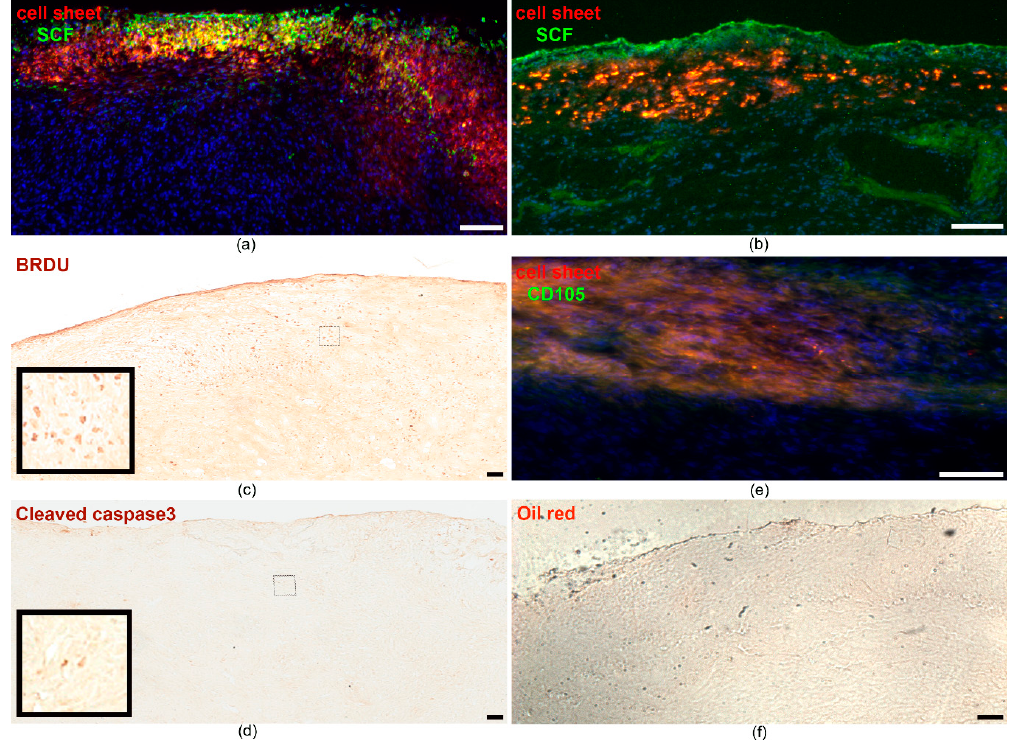
Figure 3. SCF-MSC CS integration into myocardium tissue and transgene expression at day 5 ( a ) and 14 ( b ) after MI induction. Representative images of the infarction area that is covered by the cell sheet comprised of PKH26-labeled cells (red). Specific staining indicates SCF protein (green) distribution throughout the muscle tissue; ( c ) Bromodeoxyuridine (BRDU) immunohistostaining to identify proliferating cells in the graft and adjacent tissue (day 14). The small square bar indicate the area of the section where the magnified view (large square bar) was taken from; ( d ) Immunohistostaining for cleaved caspase 3 to identify apoptotic cells in the graft and adjacent tissue (day 14). The small square bar indicate the area of the section where the magnified view (large square bar) was taken from; ( e ) Immunofluorescent staining for CD105 (green) at day 14; ( f ) Oil-red staining to identify adipose cells